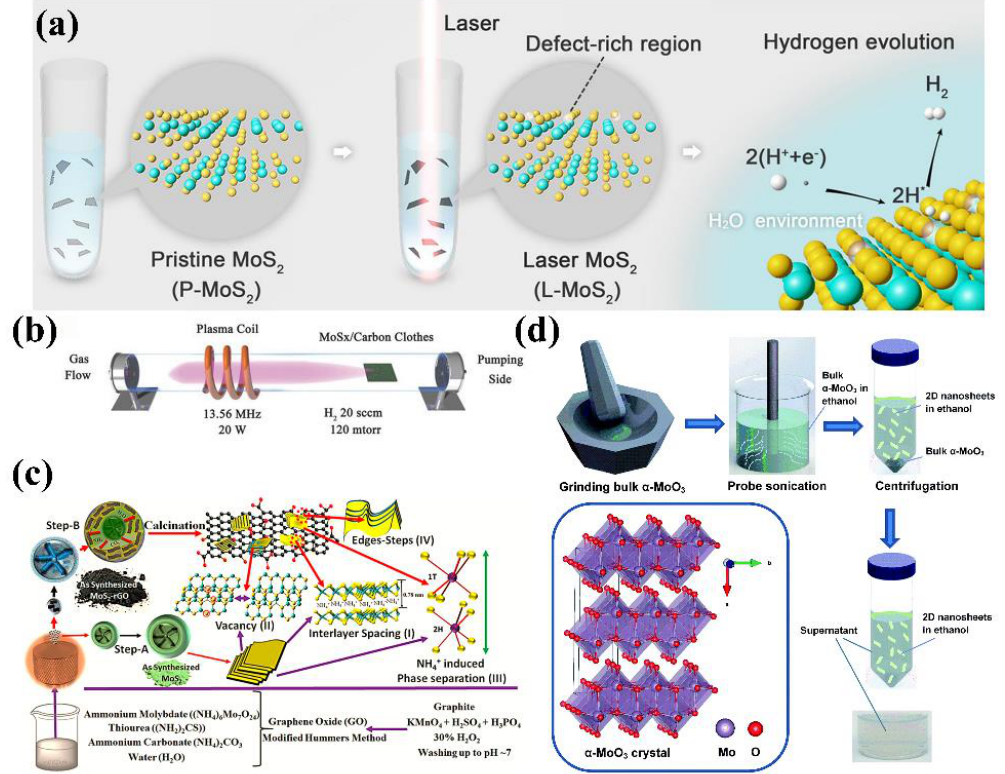
Figure 4. ( a ) synthetic procedure of L-MoS 2 . Color code: Cyan represents Mo, yellow represents S, white represents H, and transparent color represents vacancy. Copyright 2019 American Chemical Society. ( b ) schematic illustration for the experimental setup of inductively coupled plasma.